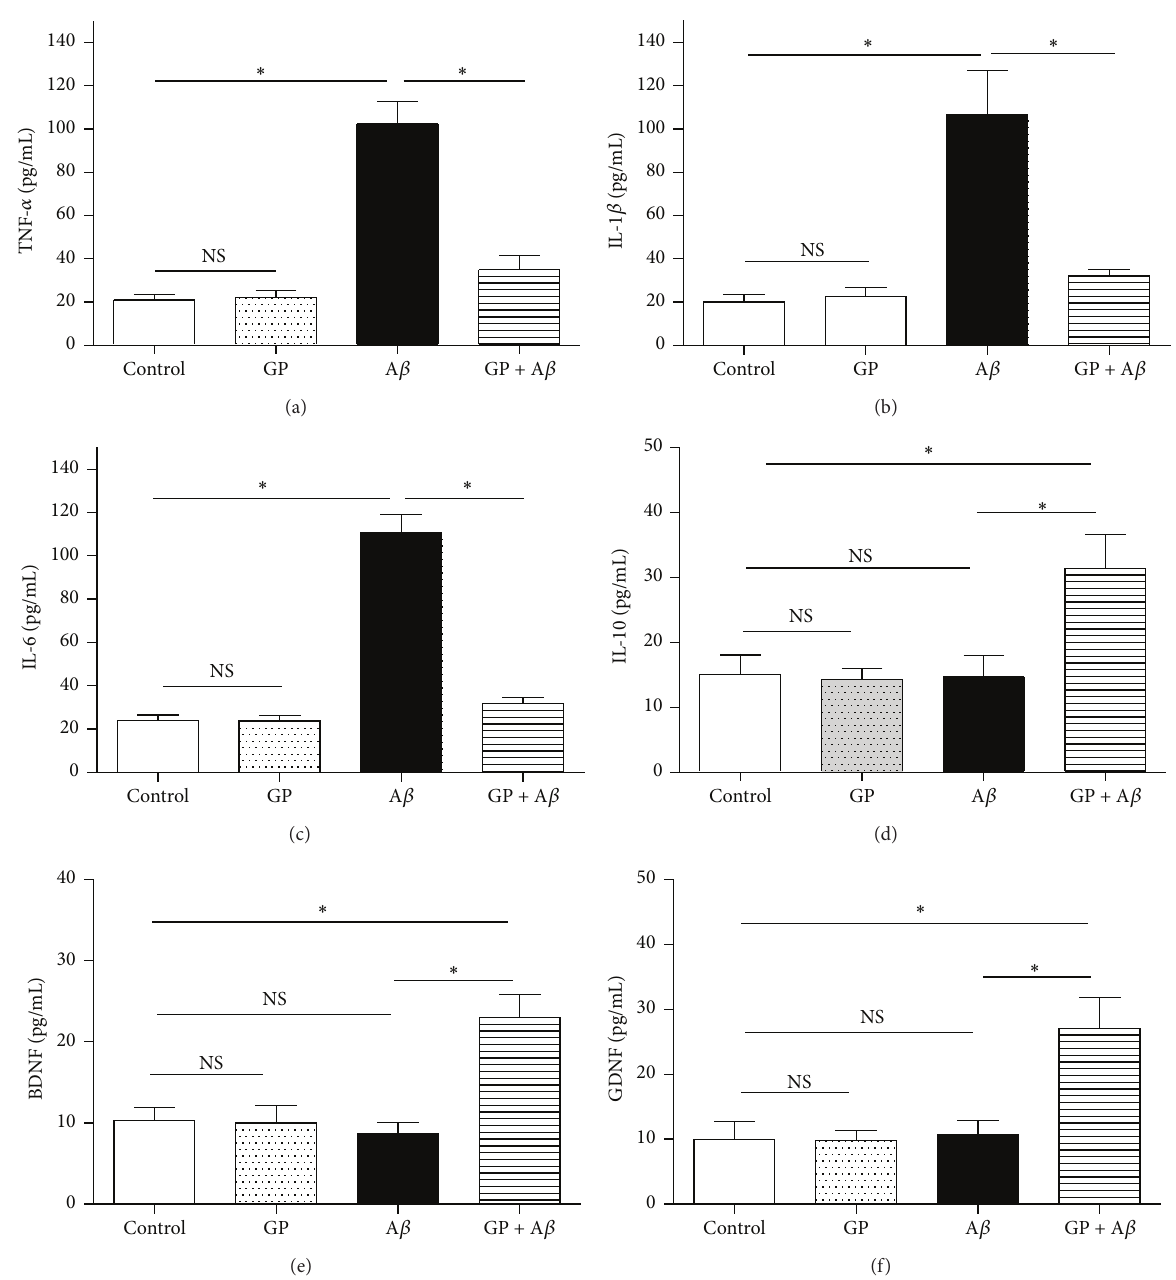
Figure 5: GP reversed A 𝛽 -induced effects on the releases of cytokines. The N9 microglial cells were divided into four groups, including control: cells cultured in normal medium; GP: cells cultured in the medium containing 50 𝜇 g/mL GP; A 𝛽 : cells cultured in the medium containing 10 𝜇 M A 𝛽 ; GP + A 𝛽 : cells cultured in the medium containing 50 𝜇 g/mL GP and 10 𝜇 M A 𝛽 . After 24-h incubation, the corresponding ELISA kits were used to evaluate the releases of cytokines, including TNF- 𝛼 (a), IL-1 𝛽 (b), IL-6 (c), IL-10 (d), BDNF (e), and GDNF (f). Data are means ± SD, 𝑛 = 6 , ∗ : 𝑃 < 0.05 , NS: no